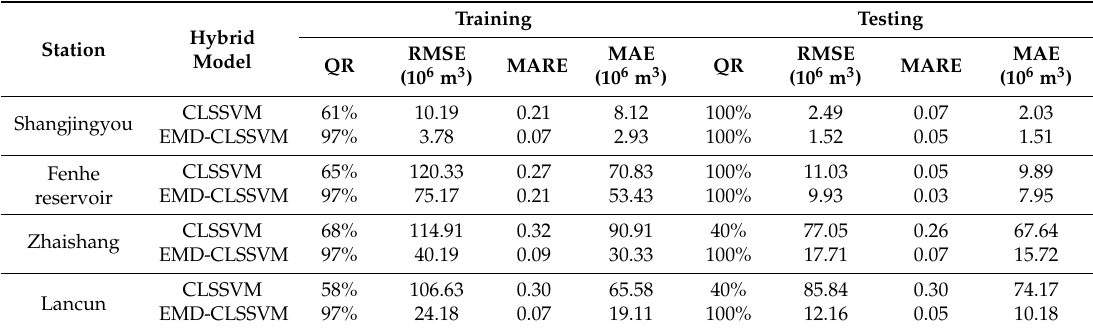
Table 4. Performance indicators of different models for four hydrologic stations during training and testing